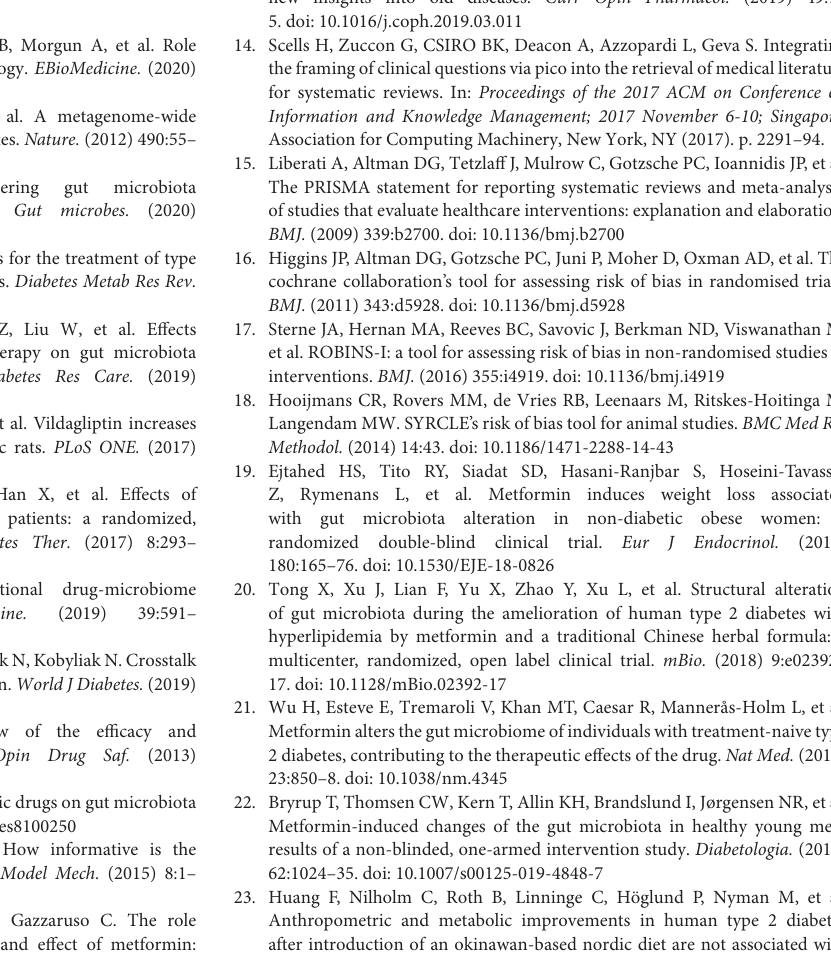
Supplementary Figure 1 | Risk of bias of randomized trials. (A) Each risk of bias item for each study. (B) Each risk of bias item across studies. Supplementary Figure 2 | Risk of bias of quasi-experimental studies. (A) Each risk of bias item for each study. (B) Each risk of bias item across studies. Supplementary Figure 3 | Risk of bias of observational studies. (A) Each risk of bias item for each study. (B) Each risk of bias item across studies. Supplementary Figure 4 | Risk of bias of animal studies. (A) Each risk of bias item for each study. (B) Each risk of bias item across studies. Supplementary Table 1 | Searching strategy. Supplementary Table 2 | Characteristics of housing and dietary of studied animals.